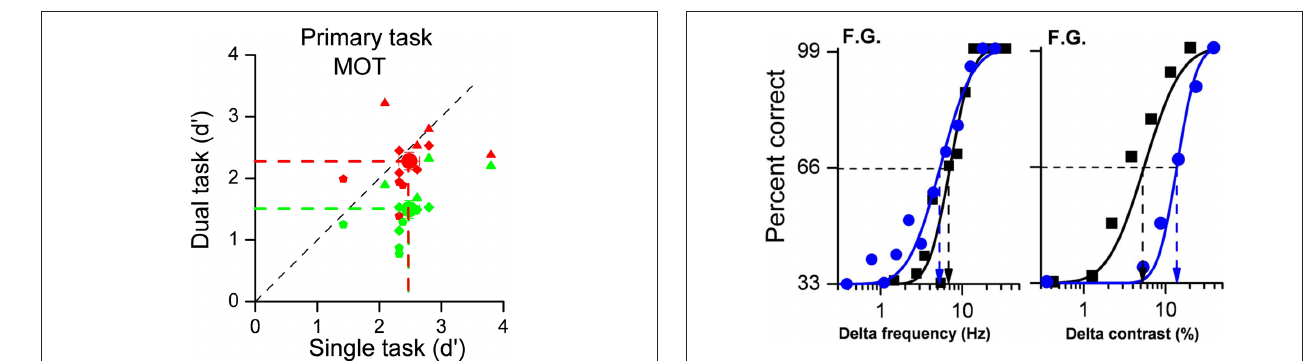
Figure 2 | Psychometric functions for auditory frequency discrimination (left panel) and visual contrast discrimination (right panel) for subjects F.g. Performance in the auditory task was almost identical when frequency discrimination was performed alone (black data points and lines) or together with a visual MOT task (blue data points and lines) as shown by the almost overlapping curves. However, when the two concurrent tasks were of the same sensory modality (vision), subject performance was dramatically reduced by around a factor of 3.